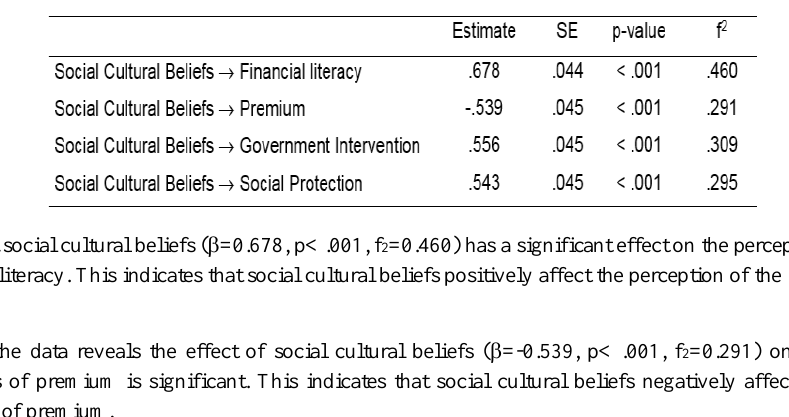
Table 13: The Effect of Social Cultural Beliefs on the Perception of the Respondents on Microinsurance Dimension